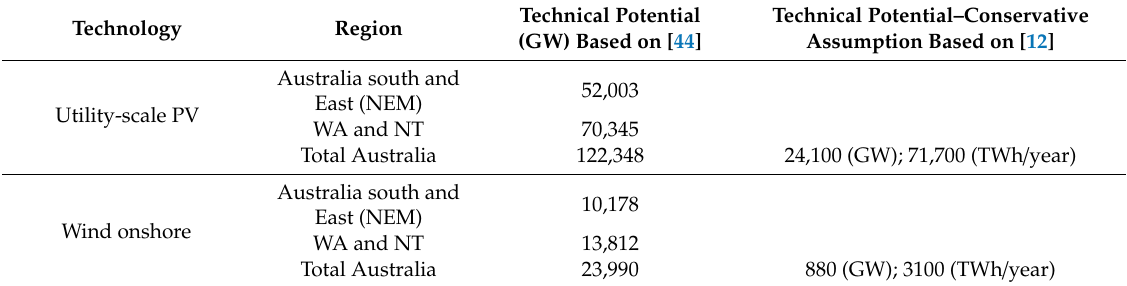
Table A11. Maximum installable capacity and generated electricity for utility scale PV and wind onshore according to the available potential. Data based on [12,44].